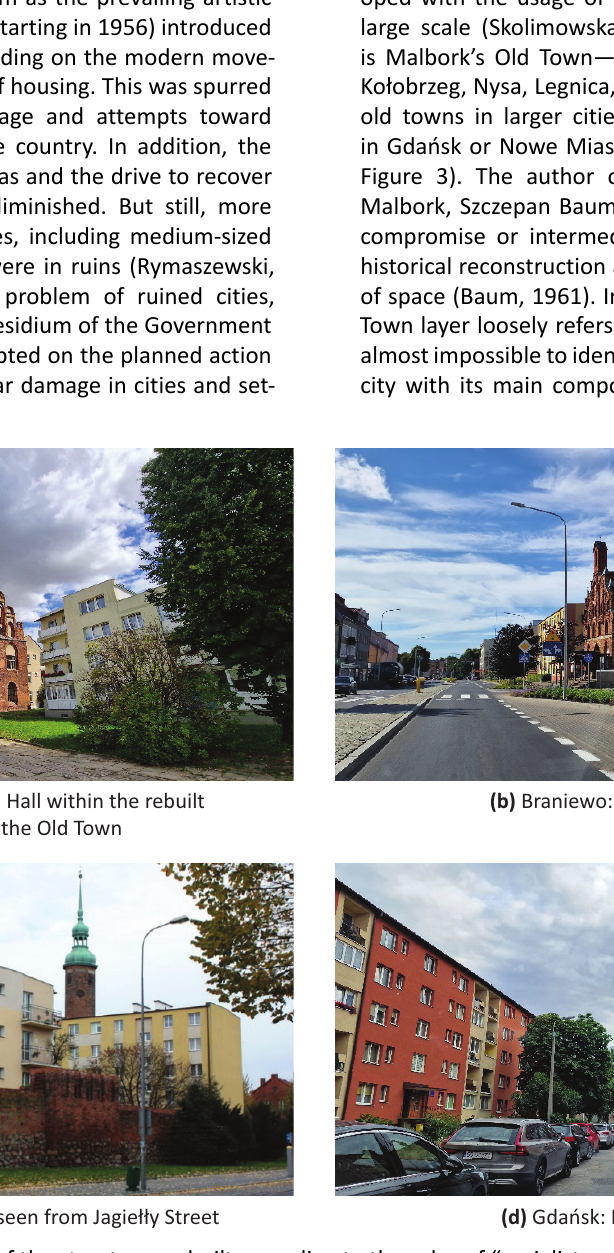
Figure 3. Selected examples of the structures rebuilt according to the rules of “socialist modernism.” Urban Planning, 2023, Volume 8, Issue 1, Pages